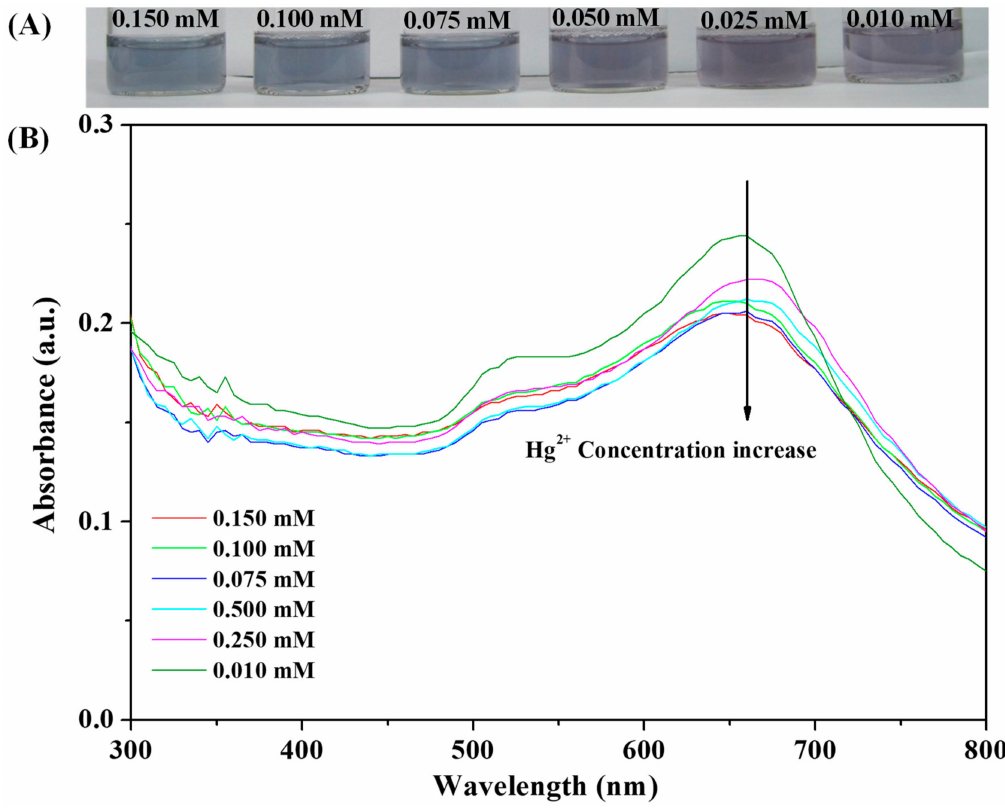
Figure 5. ( A ) Photographs and ( B ) absorption spectrum of citrate-capped AuNPs (0.798 nM) with di ff erent concentration of Hg 2 + (from 0.01 to 0.15 mM) and 0.67 mM PEG in solution after adding 50 µ M